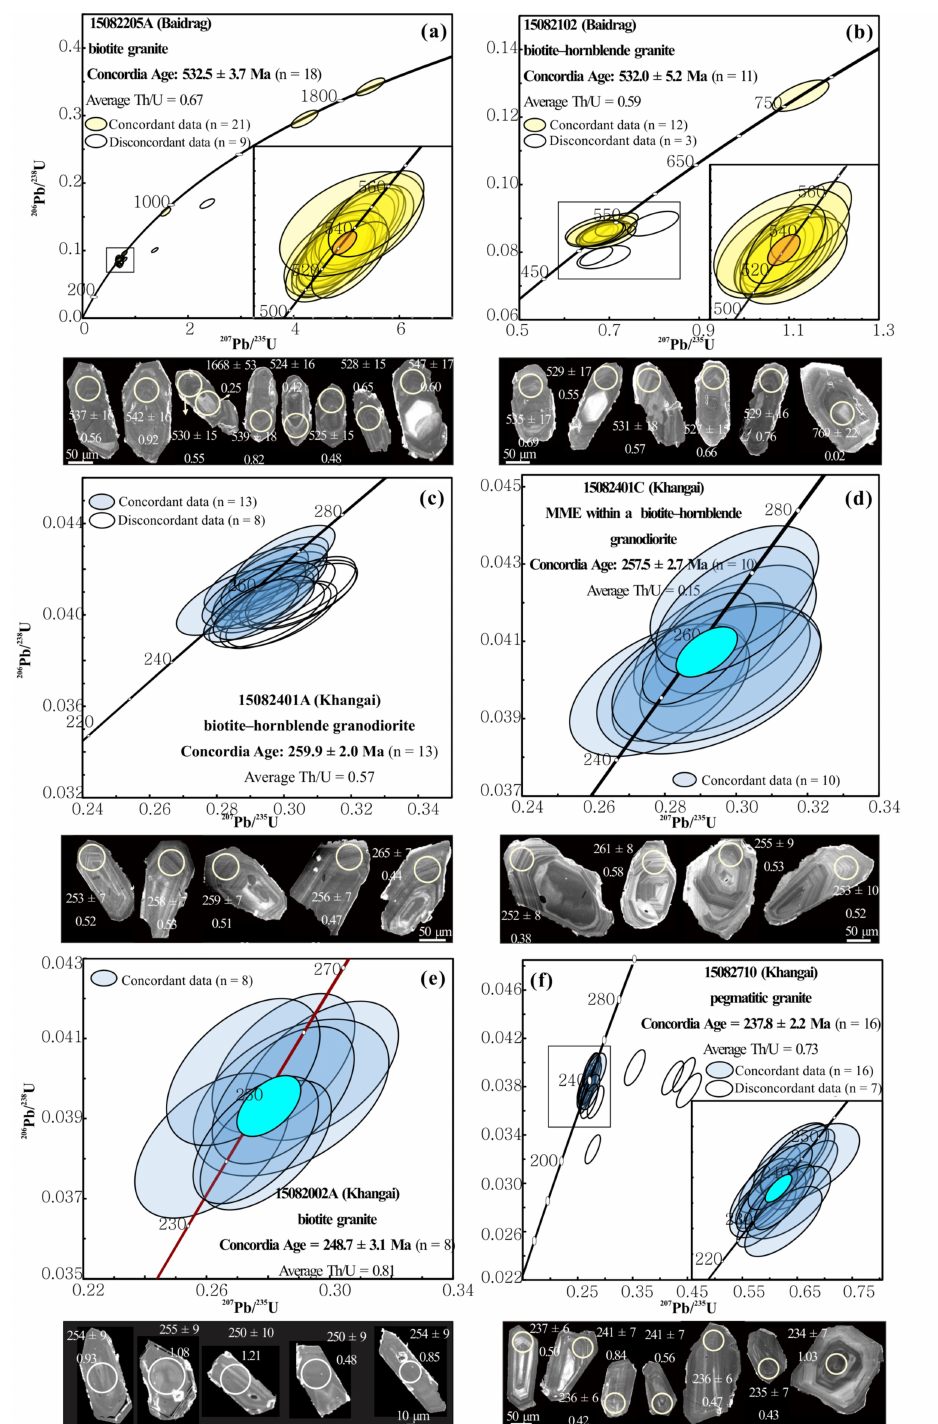
Fig. 4. Zircon U–Pb concordia diagrams, cathodoluminescene (CL) images with analysis spots for granitoids within the Baidrag and Khangai areas. The concordant and discordant data are shown as colored and colorless ellipses, respectively. The inset figures are enlarged views of the areas enclosed in black boxes. (a) Biotite granite (sample 15082205A), (b) Biotite–hornblende granite (sample 15082102), (c) Biotite–hornblende granodiorite (sample 15082401A), (d) A MME within a biotite– hornblende granodiorite (sample 15082401C), (e) Biotite granite (sample 15082002A), (f) Pegmatitic granite (sample